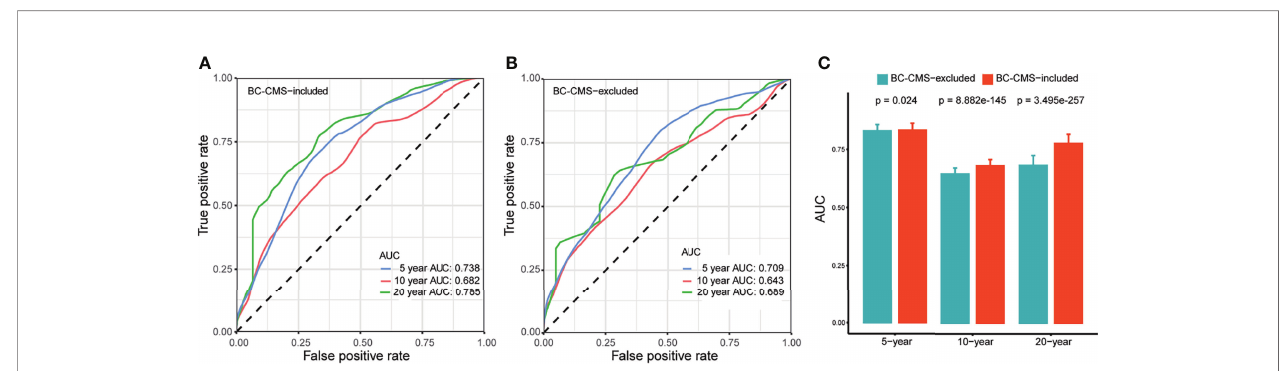
FIGURE 6 | BC-CMS signi fi cantly improves prognosis prediction of BRCA patients. (A) ROC curves for the prediction of 5-, 10-, and 20-year overall survival of BRCA patients using all signi fi cant prognostic factors; (B) ROC curves for the prediction of 5-, 10-, and 20-year overall survival of BRCA patients using all signi fi cant prognostic factors except BC-CMS; (C) Comparison of predictive power between BC-CMS included and BC-CMS excluded models using bootstrapping strategy with 80% sampling rate and 1,000